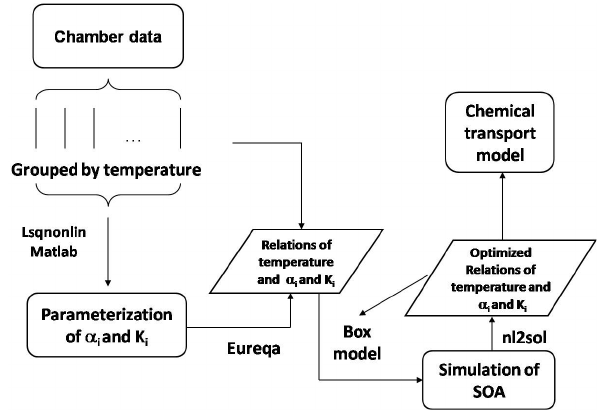
Fig. 2. Technical frame of parameterization of mass stoichiometric coefficients and partitioning coefficients. First step: grouping ex- perimental data, second step: fitting parameters in each group, third step: deriving temperature dependent functions, last step: optimiz- ing parameter